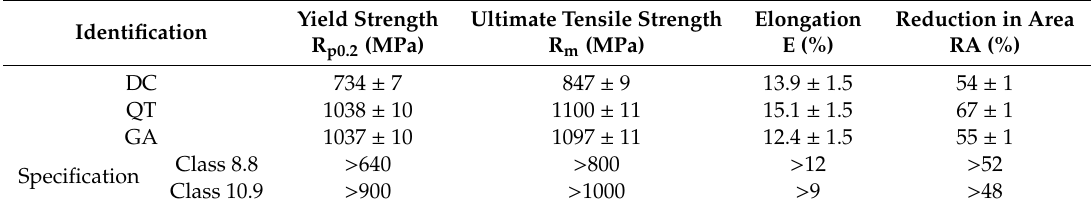
Table 4. Verification of the mechanical properties of 30MnB5 samples. The tolerances correspond to the expanded measurement uncertainty of each result (K =